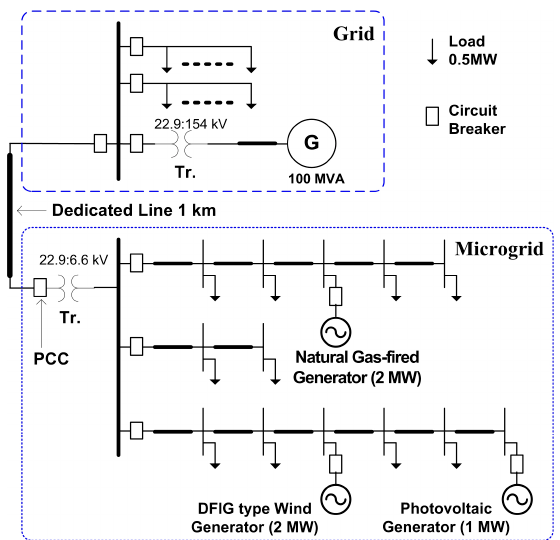
Figure 2. Single-line diagram of the model